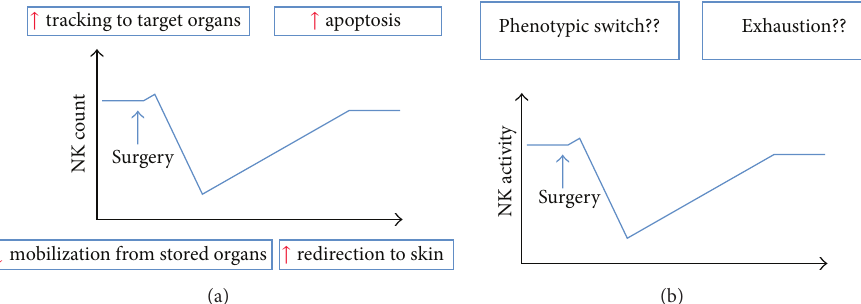
Figure 2: Postulated mechanisms behind the observed quantitative (a) and qualitative (b) changes in natural killer (NK) cells during and after